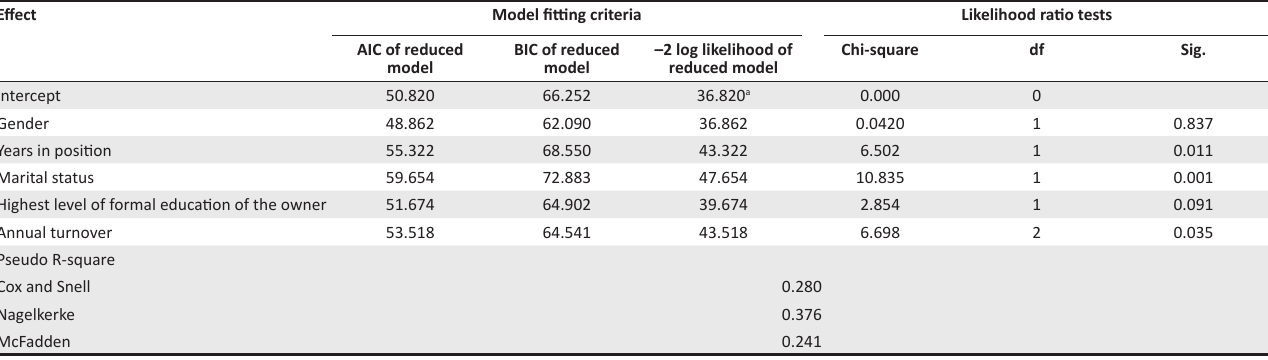
TABLE 4b: Variables used in the multivariate regression